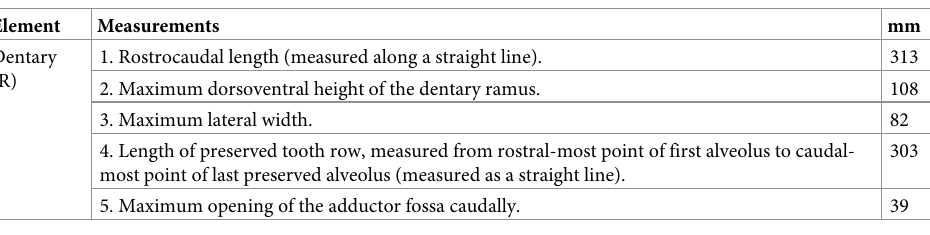
Table 1. Measurements of